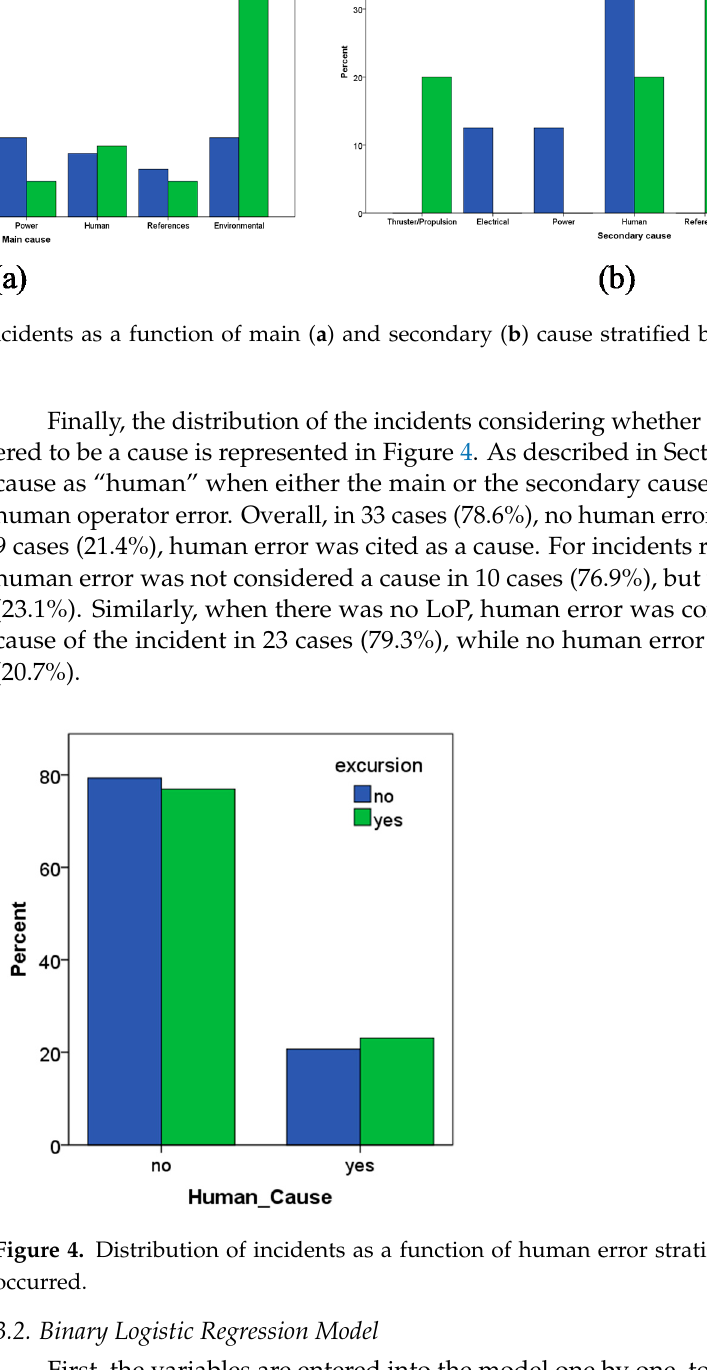
Figure 3. Distribution of incidents as a function of main ( a ) and secondary ( b ) cause stratified by whether excursion occurred.